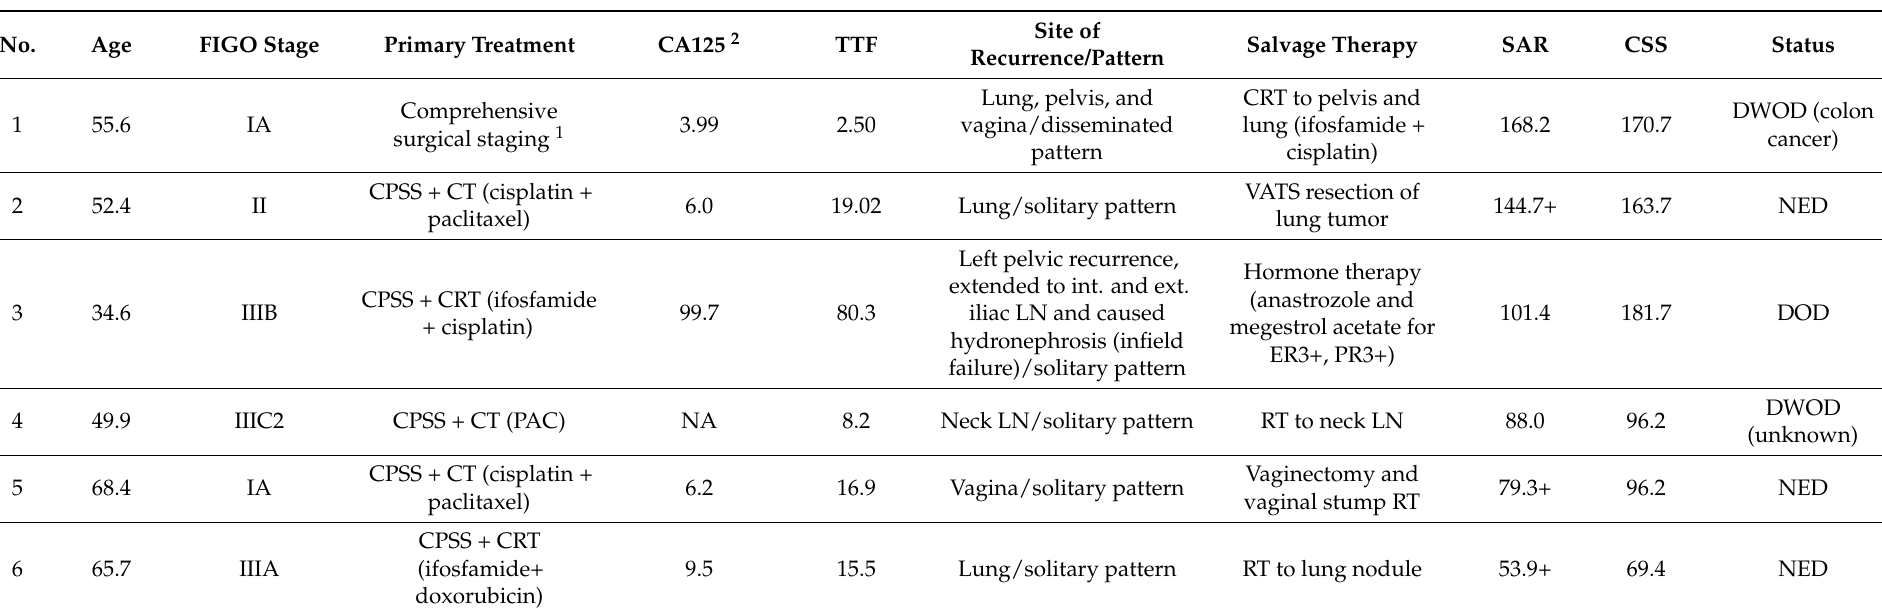
Table 5. Clinical features of long-term survivors (survival after recurrence > 50 months) in recurrent/progressive uterine carcinosarcoma